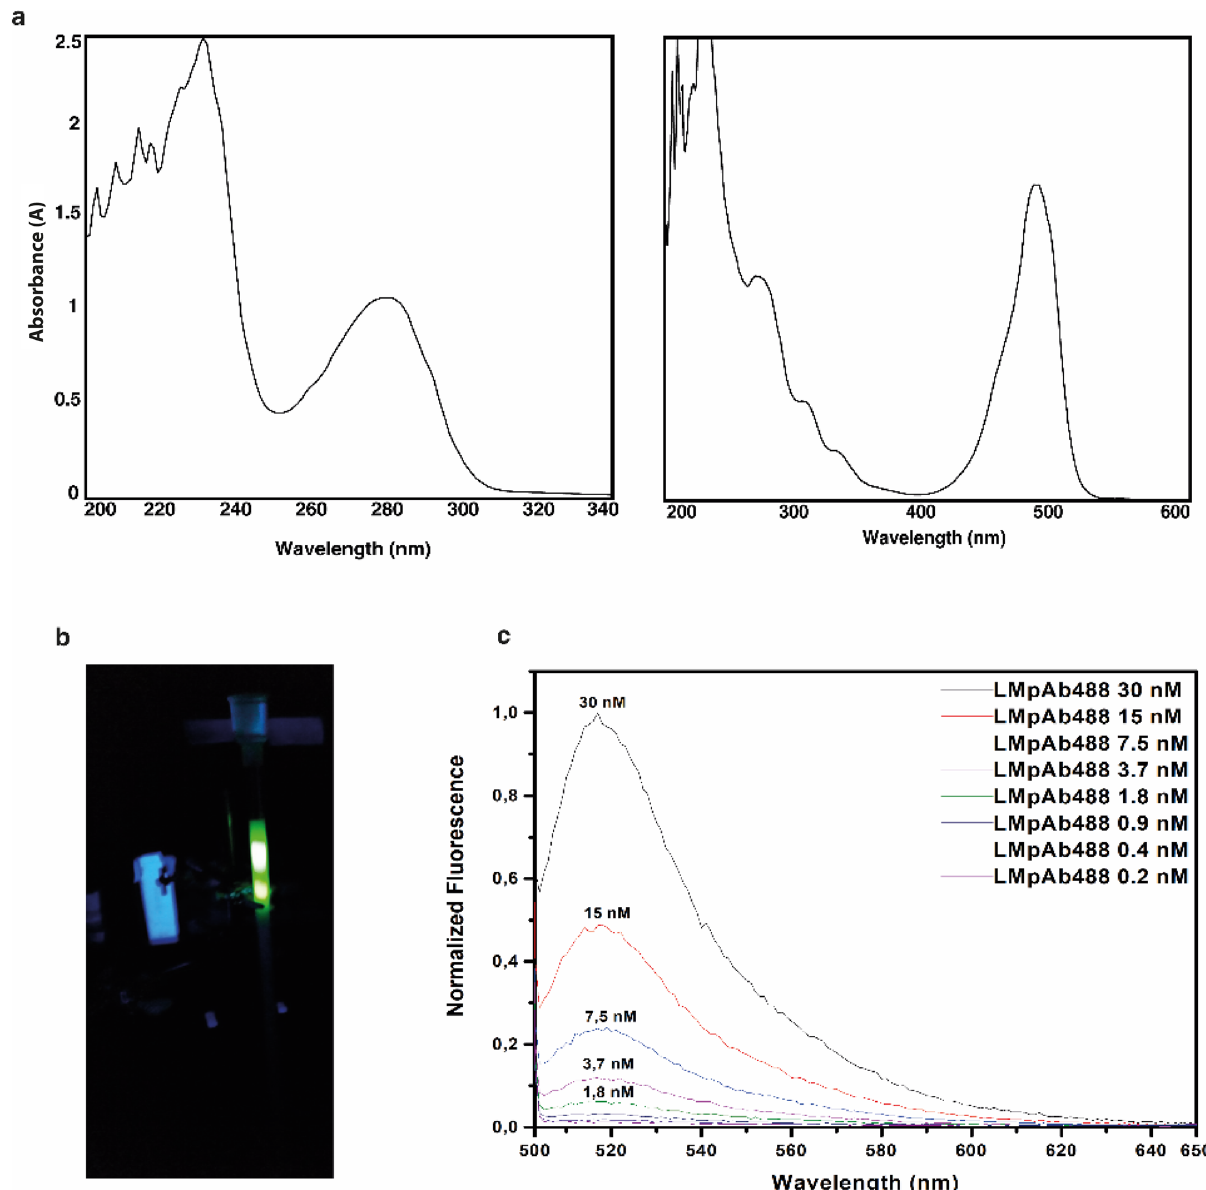
Figure 3. Labelling of the LM pAb with Alexa Fluor 488 dye and its fluorescence emission analysis. (a) Absorbance of LM pAb -on the left- and LMpAb488 -on the right-. After the labelling procedure, appeared an absorbance peak at 495 nm that confirmed the presence of dye bound to the antibody. (b) Exclusion chromatography phase: two peaks are present, -bottom- labelled antibody fraction and -top- the unreacted probe. (c) Normalized fluorescence emission spectra of LMpAb488 excited at 495 nm. The emission peak centered at 520